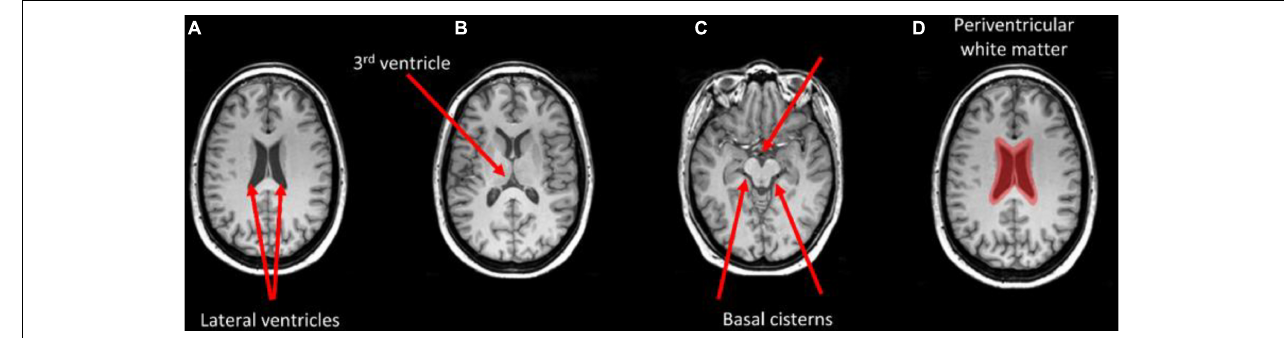
FIGURE 5 | Brain areas that correspond with regions highlighted in the grad-CAM maps with threshold above 0.85. Arrows indicate the lateral ventricles (A) , the third ventricle (B) , and the basal cisterns (C) . Periventricular white matter is highlighted in (D) .